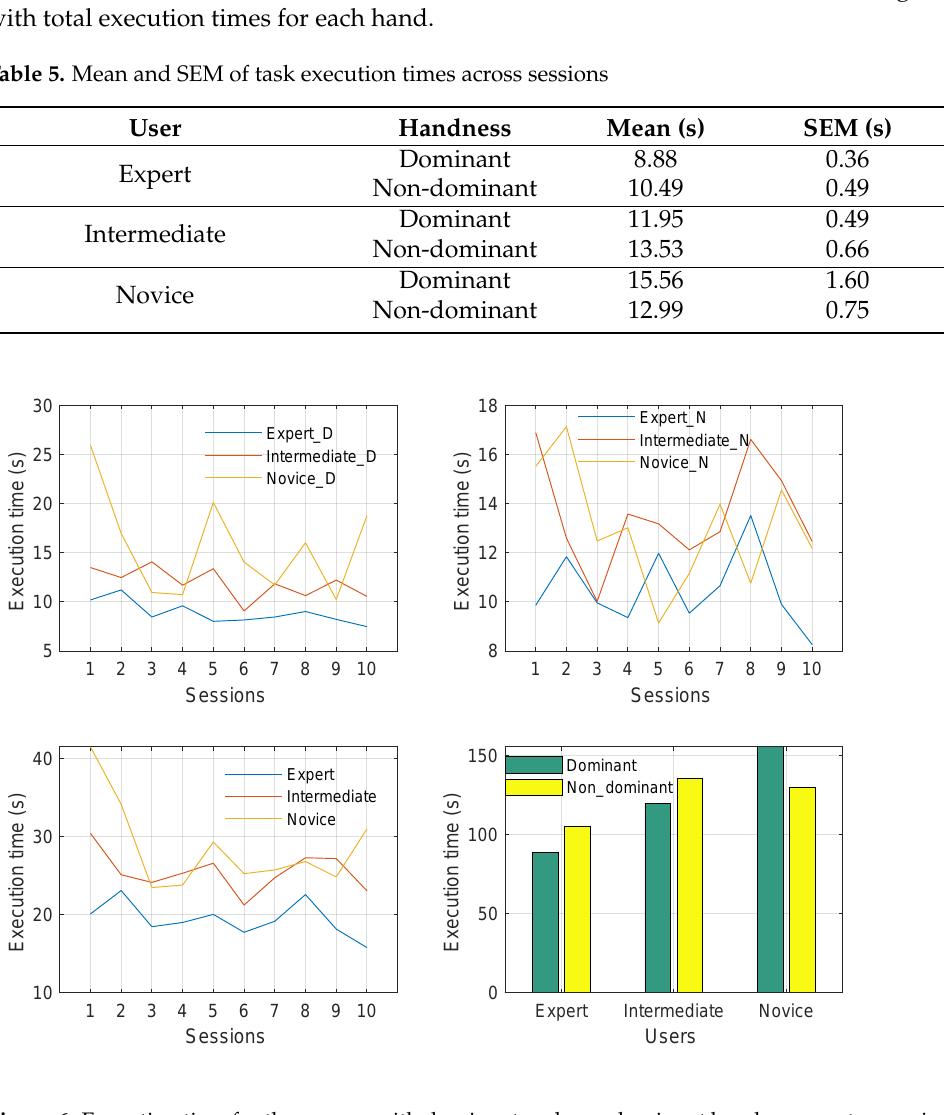
Figure 6. Execution time for three users with dominant and non-dominant hands among ten